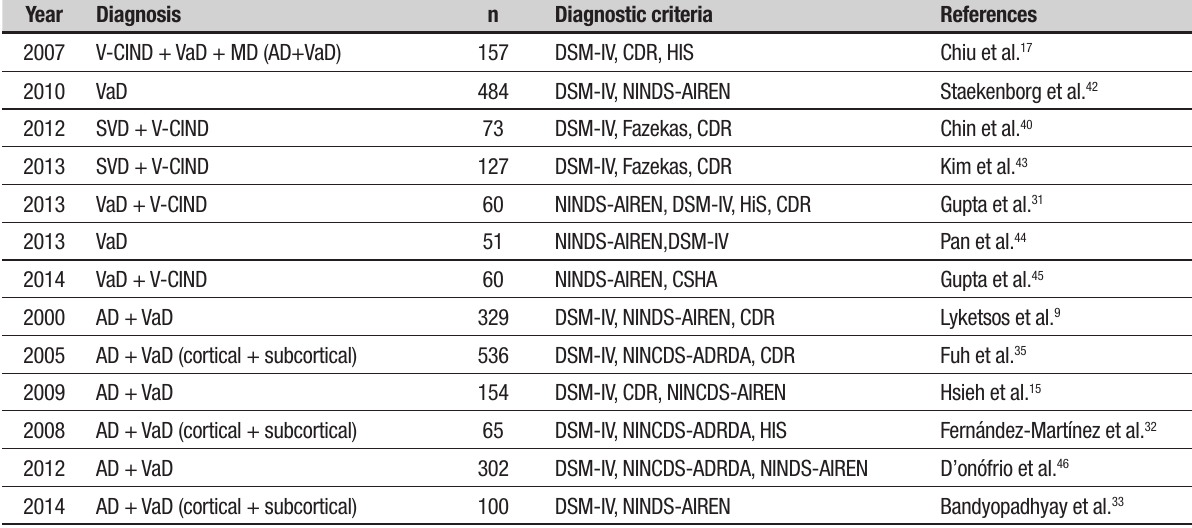
Table 1. Characteristics of samples, diagnostic groups and operational criteria in the studies selected. Year Diagnosis n Diagnostic